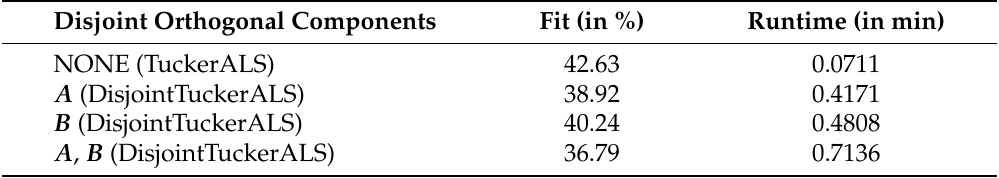
Table 18. Comparison of fit and runtime for Chopin’s preludes